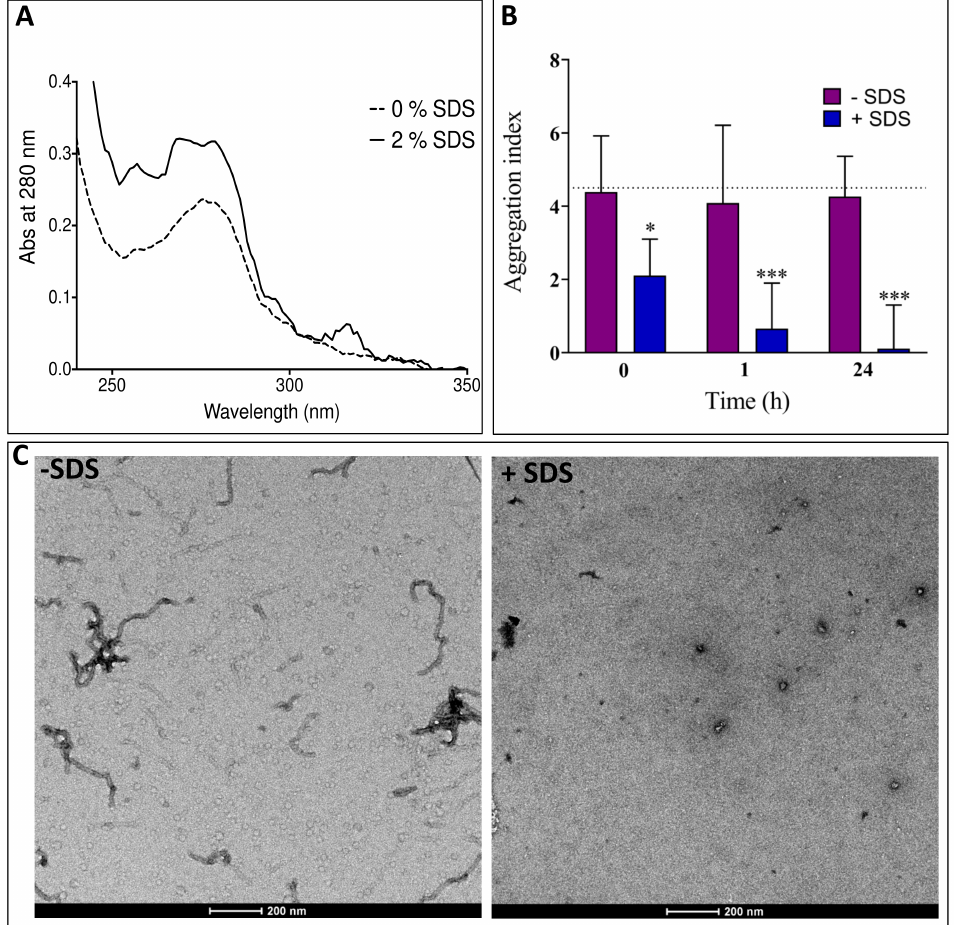
Figure 9. ( A ) Absorbance at 280 nm of the filtrate of a sample of PNT3 at 100 µ M after 56 h of incubation at 37 ◦ C before (dashed line) and after (continuous line) exposure to 2% SDS, and 10 min incubation at 37 ◦ C. Exposure of SDS enables more material to pass through the filter. ( B ) Aggregation index of a fibrillated sample of PNT3 at 100 µ M before and after incubation at RT either in the presence or in the absence of 2% SDS. Exposure to SDS reduces the aggregation index. The error bar corresponds to the standard deviation with n = 5. The asterisks denote a statistically significant difference with respect to the sample without SDS (* p < 0.0265; *** p < 0.0004, one-way ANOVA test). ( C ) Micrographs of a PNT3 sample at 200 µ M after 56 h of incubation at 37 ◦ C either in the absence or in the presence of 5 mM (1.44 mg mL − 1 )